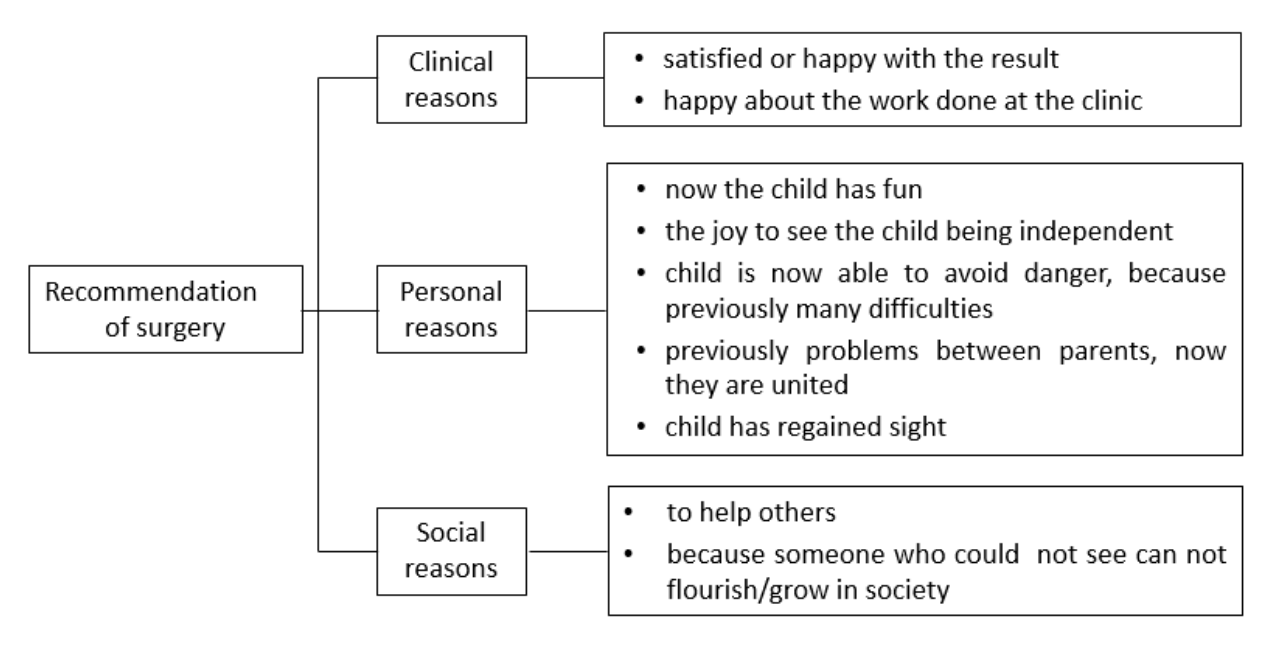
Figure 2. Recommendations of cataract surgery to others.